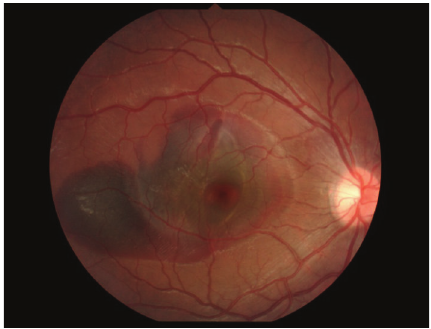
Figure 3: Choroidal rupture observed after displacement.